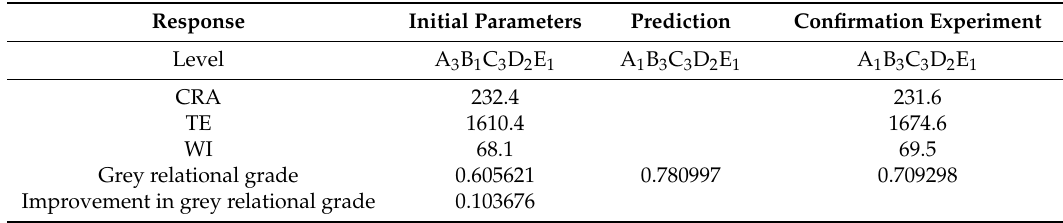
Table 14. Results of the confirmation experiment.